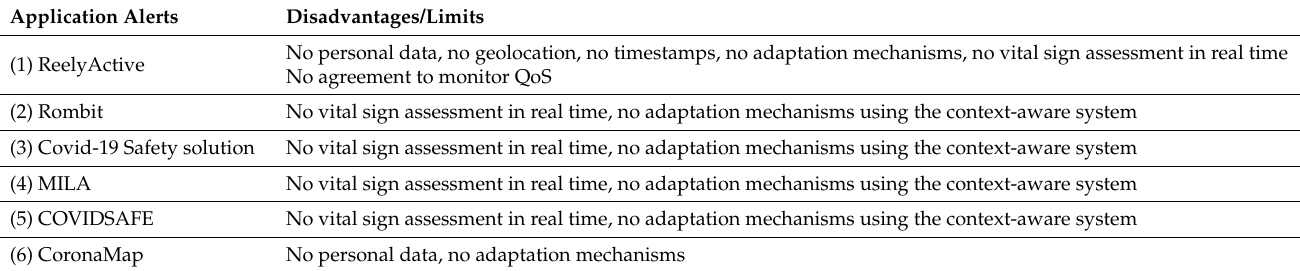
Table 1. Existing COVID-19 alert